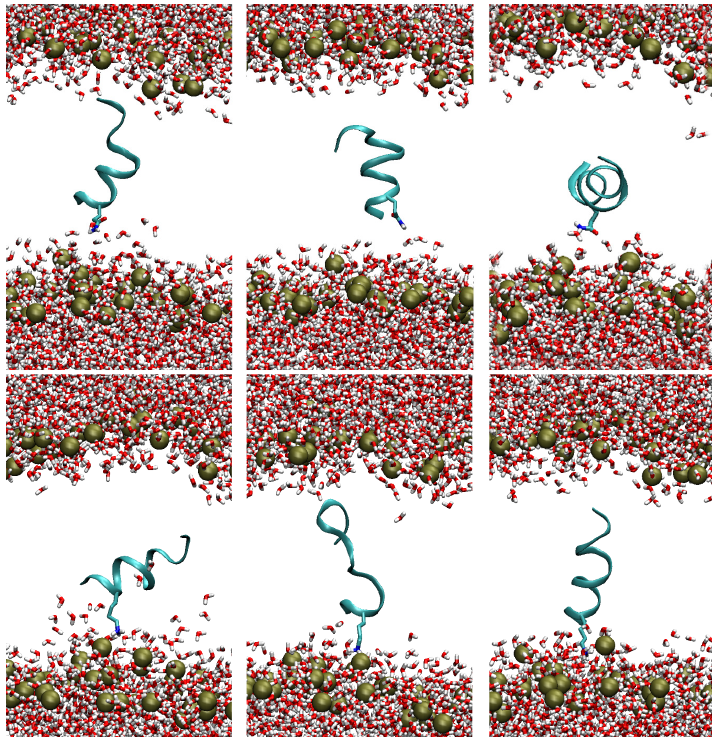
Figure 3. Representative structures for each one of the three clusters that characterize the configurations sampled in the global minimum of the PMF profile, as obtained using the g_cluster tool in the GROMACS software package. The structures reported above refer to the TempL peptide, those reported below to Q3K-TempL. The phosphorus atoms of the lipid-A, marking the position of the lipid polar heads, are indicated as gold spheres. The peptide backbone is reported as a cyan ribbon, the water molecules and the third residue of the peptides (Q and K in TempL and Q3K-TempL, respectively) are reported as sticks, with O, N and H atoms colored in red, blue and white, respectively. For the sake of clarity, the lipid tails are not reported.